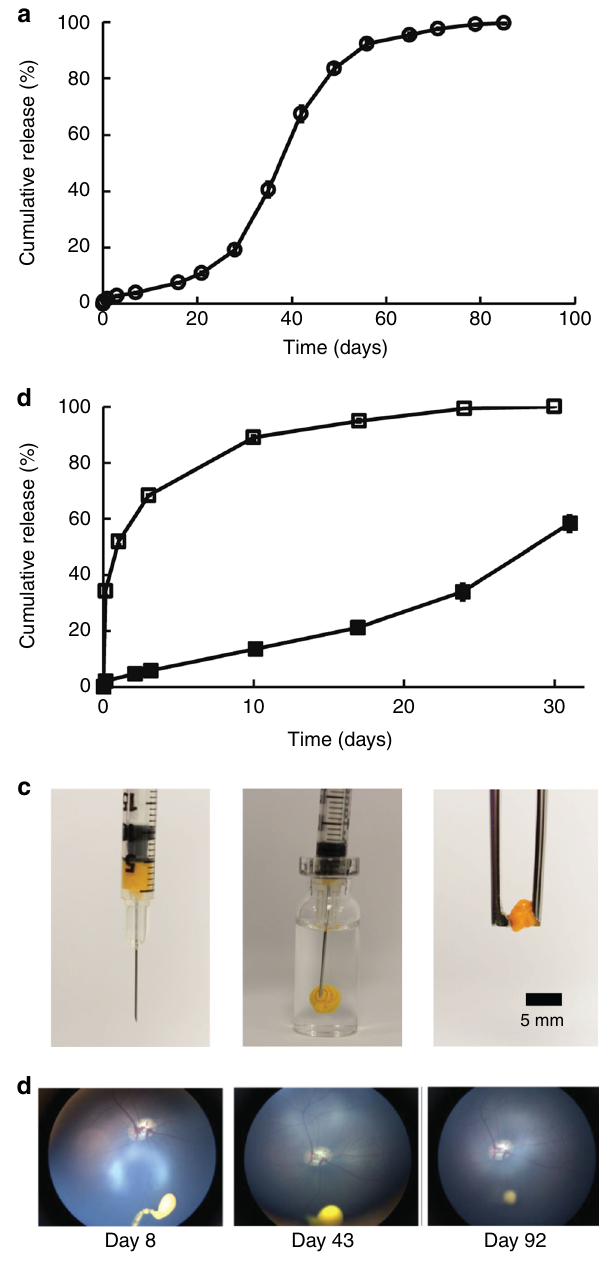
Fig. 1 Characterization of sunitinib MPs and degradation of sunitinib MP depot in the vitreous of minipigs. a Sunitinib MPs used in rabbit and minipig experiments release drug in a sustained manner for nearly 3 months in vitro at 37 °C under sink conditions. Circles are the means for two independent experiments. b Sunitinib drug suspension (open squares) was rapidly eluted and dissolved in release medium in vitro, while MPs containing an equivalent amount of sunitinib (closed squares) achieved a much more sustained release over time. c An injection of 50 µ l sunitinib MP suspension in a hyaluronate solution at 37 °C leads to the formation of a solid depot that can be isolated using a pair of forceps. d Wide- fi eld fundus photographs showing the reduction of depot size over time (Day 8, 43, and 92 post dose) in vitreous after an intravitreous injection of MP suspension containing 1 mg sunitinib in minipigs. The yellow spot near the bottom of each photo indicates the sunitinib MP depot. Source data are provided as a Source Data fi